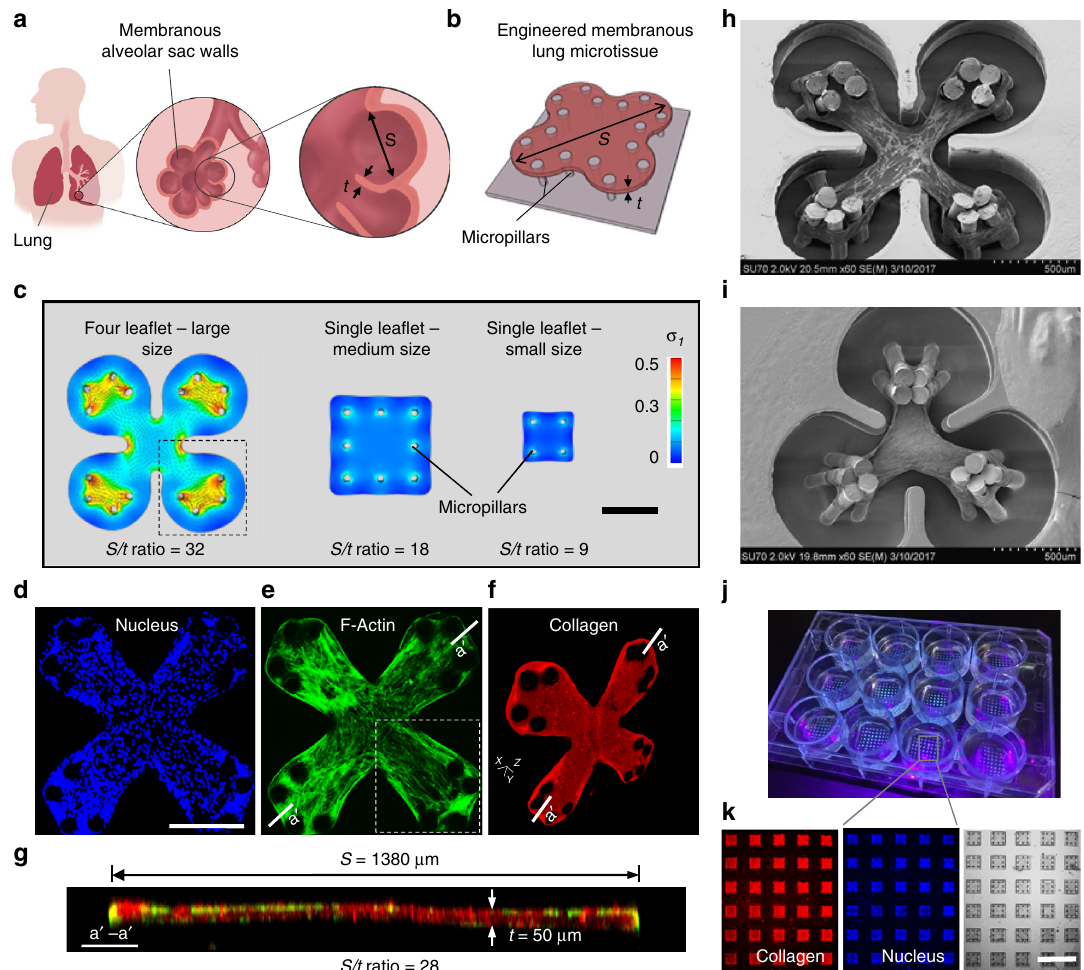
Fig. 1 Development of arrays of membranous lung microtissues. a The lung alveolar sac wall features large surface area and small tissue thickness, which is characterized by the high span length ( S ) to thickness ( t ) ratio. b Engineered lung microtissues were developed to model the membranous morphology of the alveolar sac wall. c Finite element (FE) models were developed to study the effects of microtissue geometry and size on the evolution of contractile stress during microtissue formation. First principal stress contour was plotted on deformed microtissue geometry with overlaid plot of stress vectors, where applicable. Scale bar is 500 µ m. Representative 2D-projected fl uorescent confocal images of an experimentally-created four-lea fl et lung microtissue stained for nucleus ( d ) and F-actin ( e ). Note highlighted area shows highly aligned F-actin stress fi bers running along the diagonal axis of the microtissue, matching with the direction of the principal stress in highlighted area in c . Scale bar in d is 500 µ m. f 3D isometric view of the same microtissue stained for collagen type-I. g Merged fl uorescent cross-sectional view (F-actin and collagen type-I) taken at a ′ – a ′ plane of the four-lea fl et microtissue showing S / t ratio of 28, corresponding well to alveolar sac geometry. SEM images of a four lea fl et ( h ) and a three lea fl et ( i ) human lung fi broblast-populated microtissue. j Arrays of square lung microtissues were integrated into a 12-well plate to enable parallel testing of multiple pharmacological conditions. Bright spots in each well correspond to individual microtissues. k Immuno fl uorescence imaging of the microtissue array allowed multi-parameter, phenotypic analysis of the drug ef fi cacy. Scale bar is 3